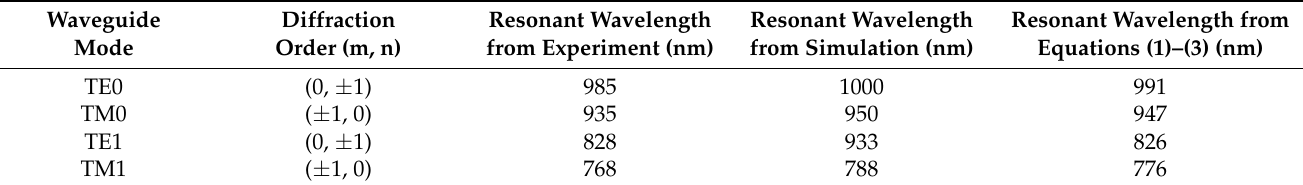
Table 1. Guided modes’ resonant wavelength observed in the transmission spectra.